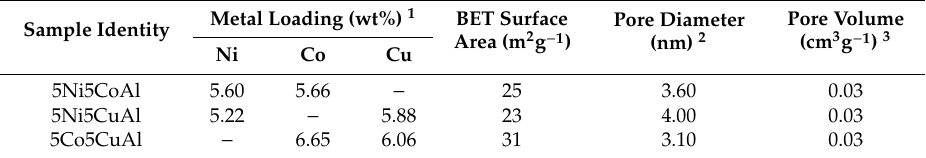
Table 1. X-ray fluorescence (XRF) elemental analysis and textural properties of the 5M5MAl catalyst